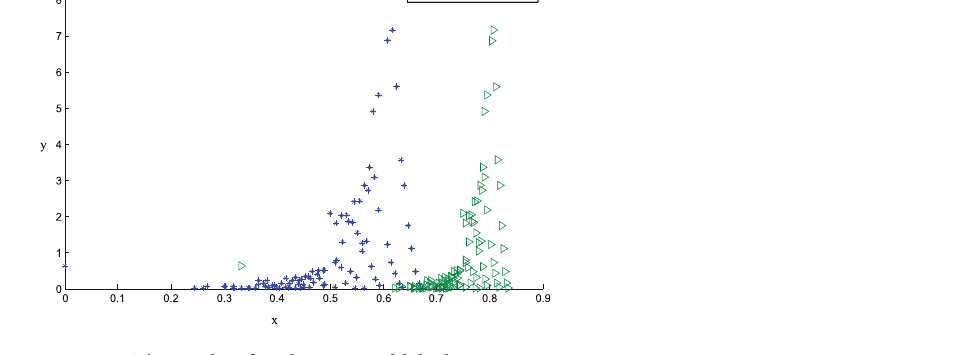
Figure 8. The results of m -distance and k